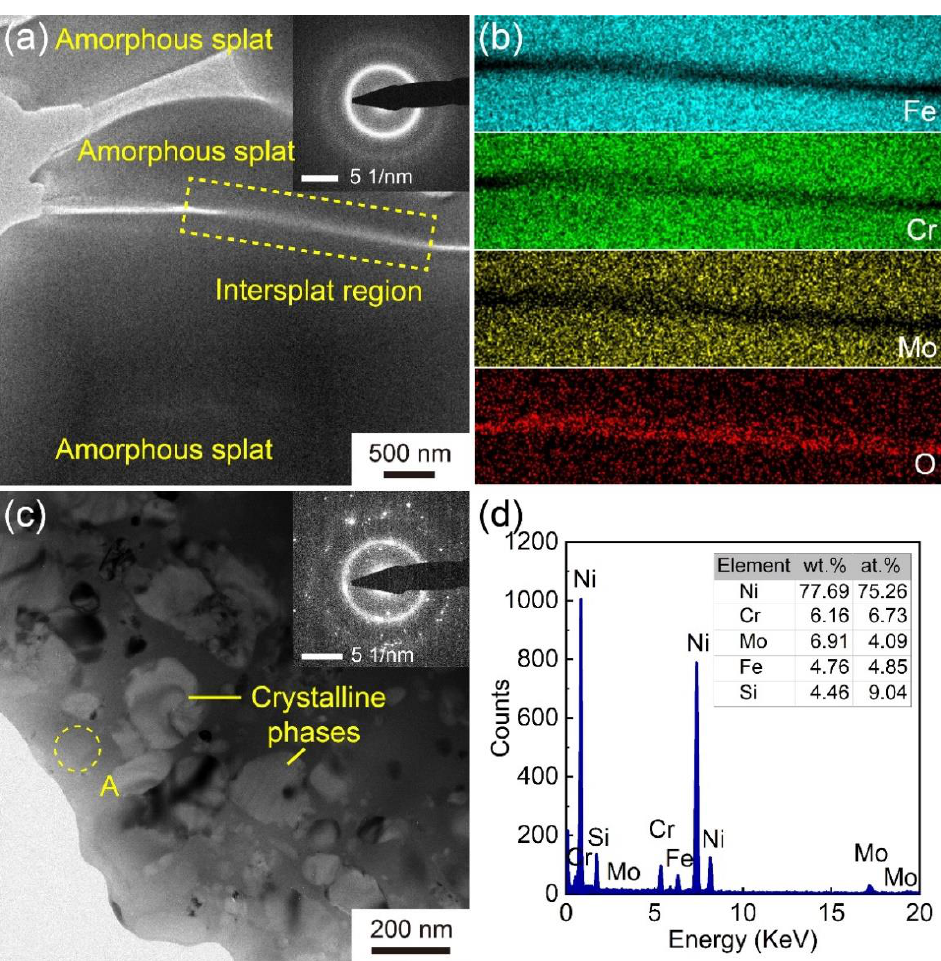
Figure 7. ( a ) Cross-sectional TEM image of Fe-based AMC in Coating D; inset in ( a ) is the SAED pattern taken from the intersplat region; ( b ) EDS element mapping of the intersplat region; ( c ) cross- sectional TEM images of Ni60 intermediate layer in Coating D; inset in ( c ) is the SAED pattern taken from the Ni60 splats; ( d ) EDS spectra of point A in ( c ).